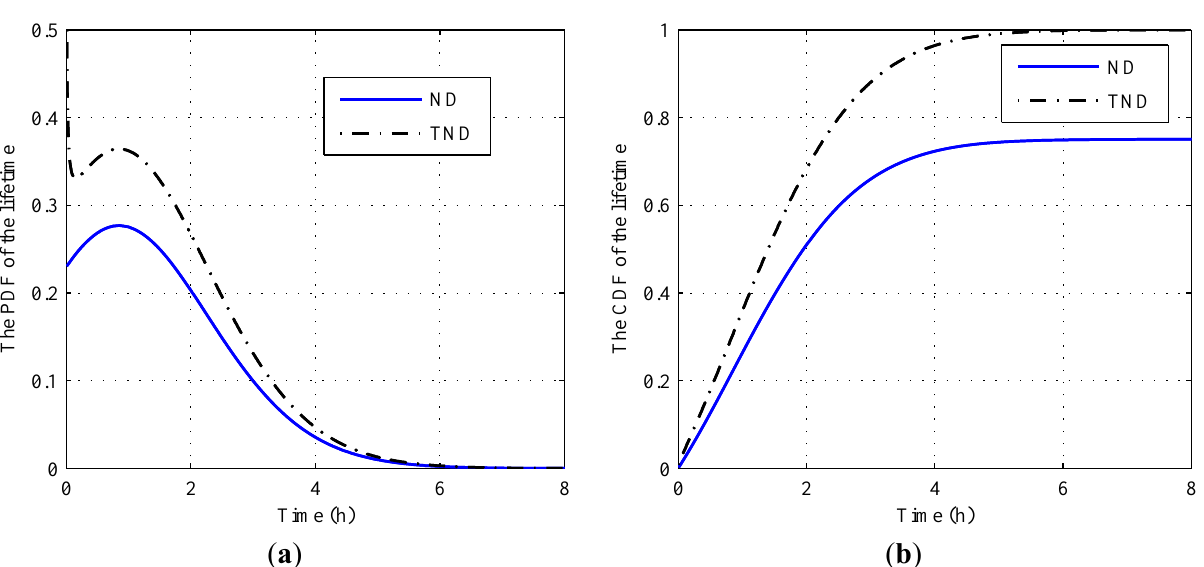
Figure 2. Comparisons between estimated lifetime distributions with traditional normal distribution (ND) and truncated normal distribution (TND): ( a ) probability distribution function (PDF); and ( b ) cumulative distribution function